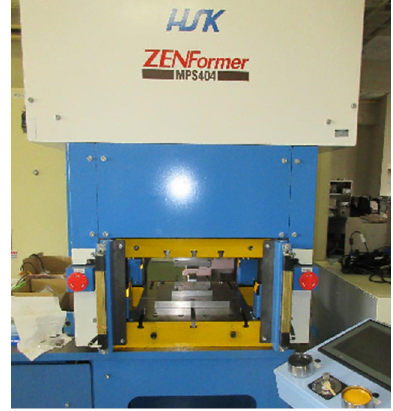
Figure 2. Upper and lower cassette die system. ( a ) Upper die set with SiC-coated SiC punch, and ( b ) lower die set with SiC-coated SiC die.